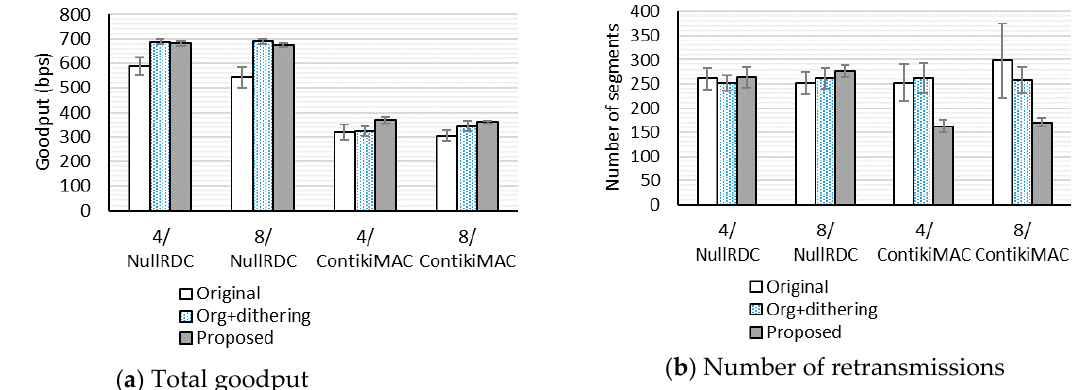
Figure 6. Effects of the link-layer queue size. Figure 6. E ff ects of the link-layer queue